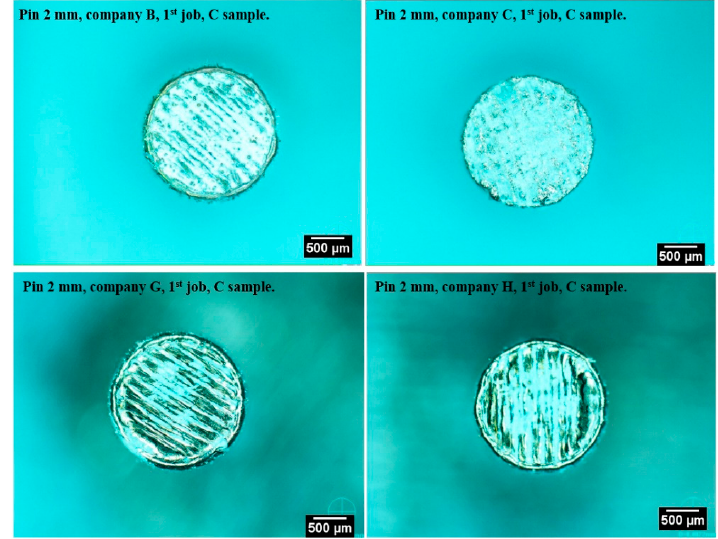
Figure 17. Optical microscope analysis of 2 mm pins from selected